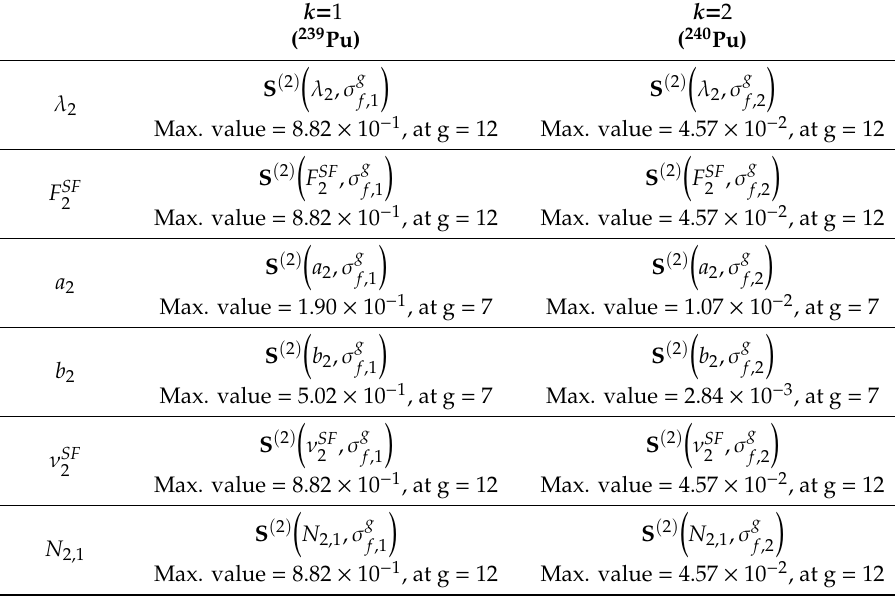
Table 12. Summary of the matrix S ( 2 ) relative sensitivities of the leakage response with respect to the source parameters of isotope 240 Pu and fission cross sections for all fissionable